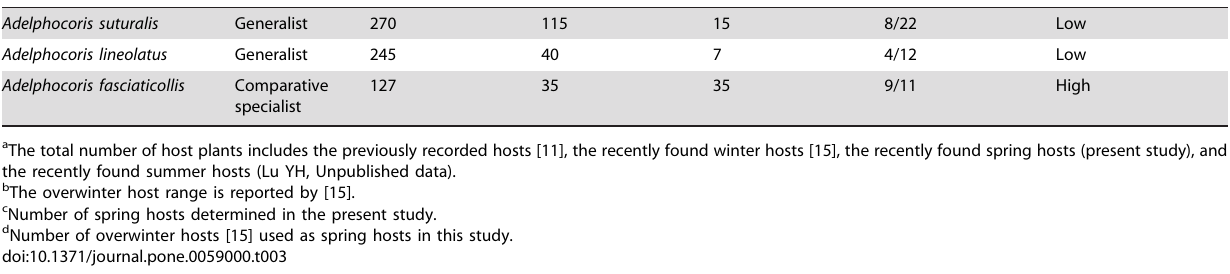
Mirid bug species Feeding types No. host plants